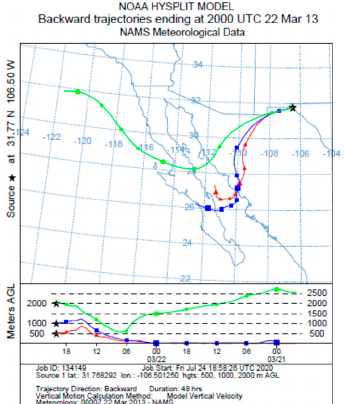
Figure 6. Backtrajectories for 22 March 2013.